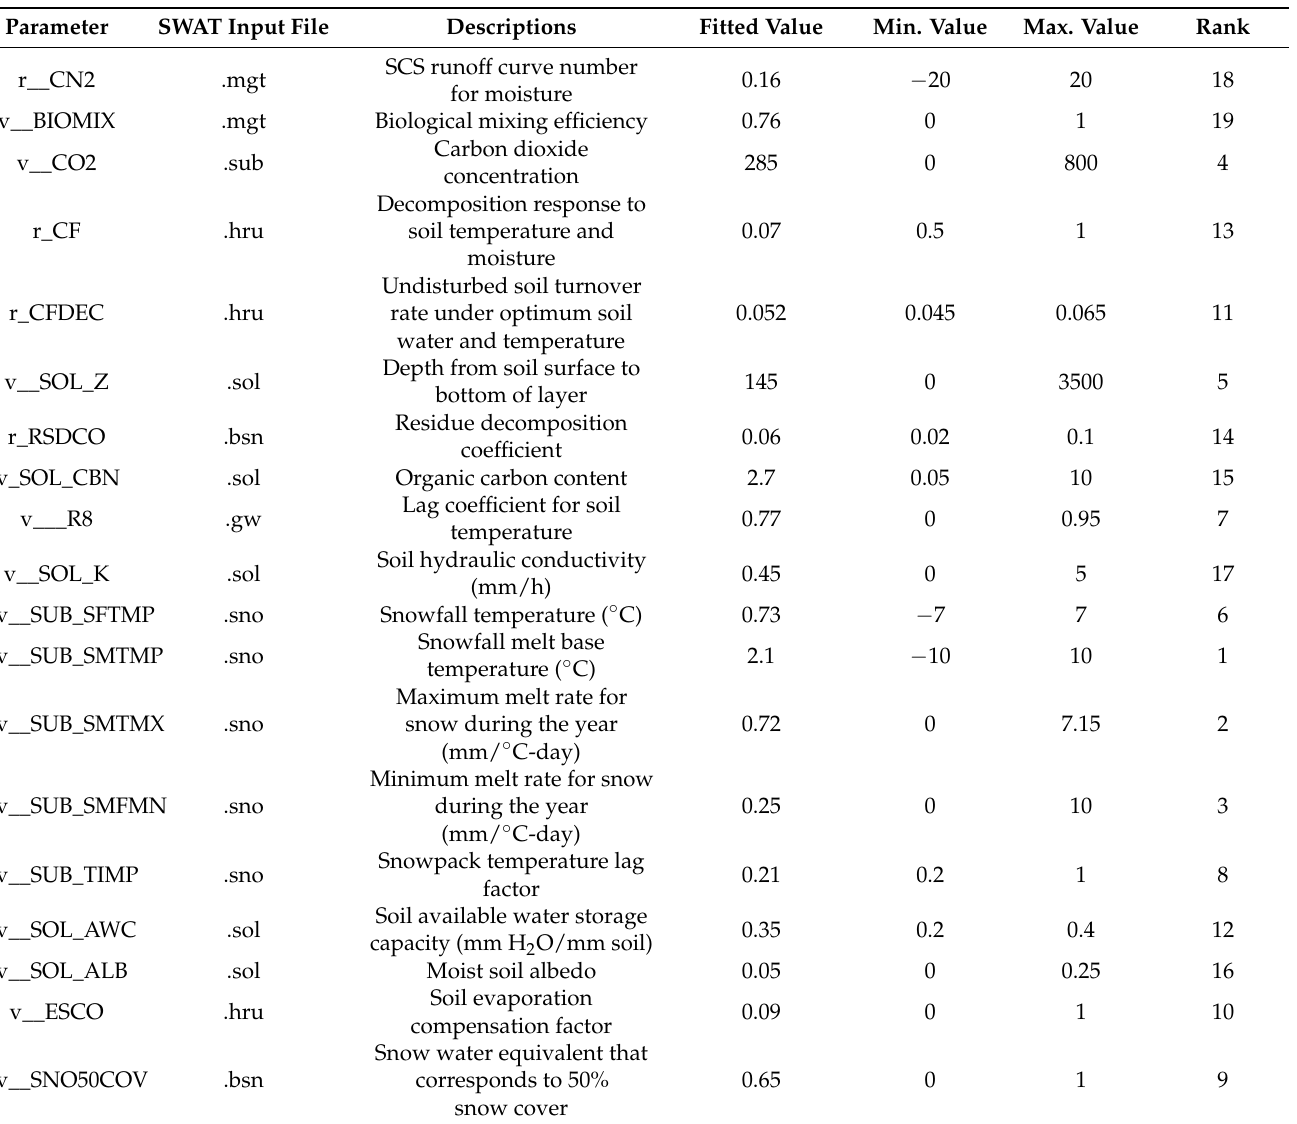
Table 2. SWAT model parameter calibration and sensitivity analysis for the Athabasca River